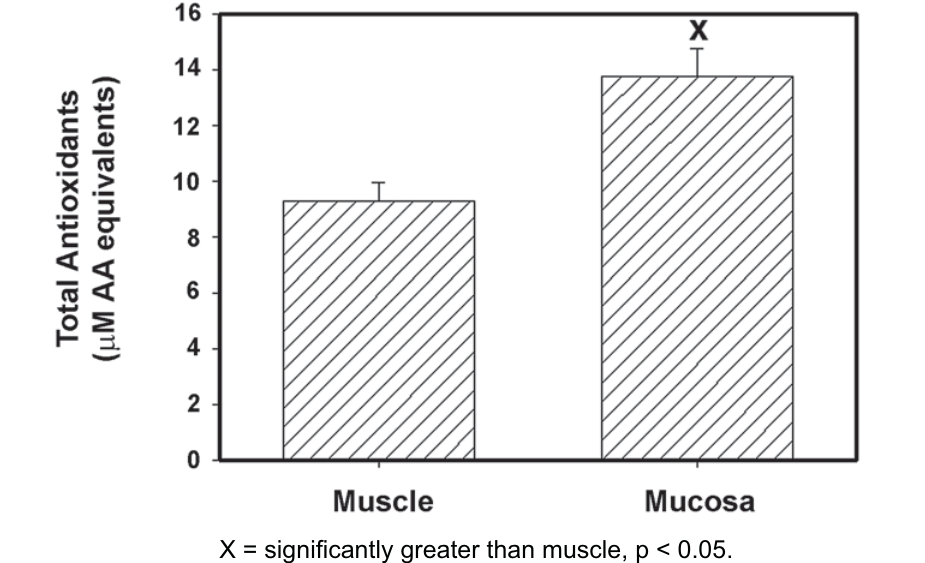
Figure 4 – CUPRAC assay for total antioxidant activity of the mucosal and muscle preparations. Each bar is the mean of 6 individual